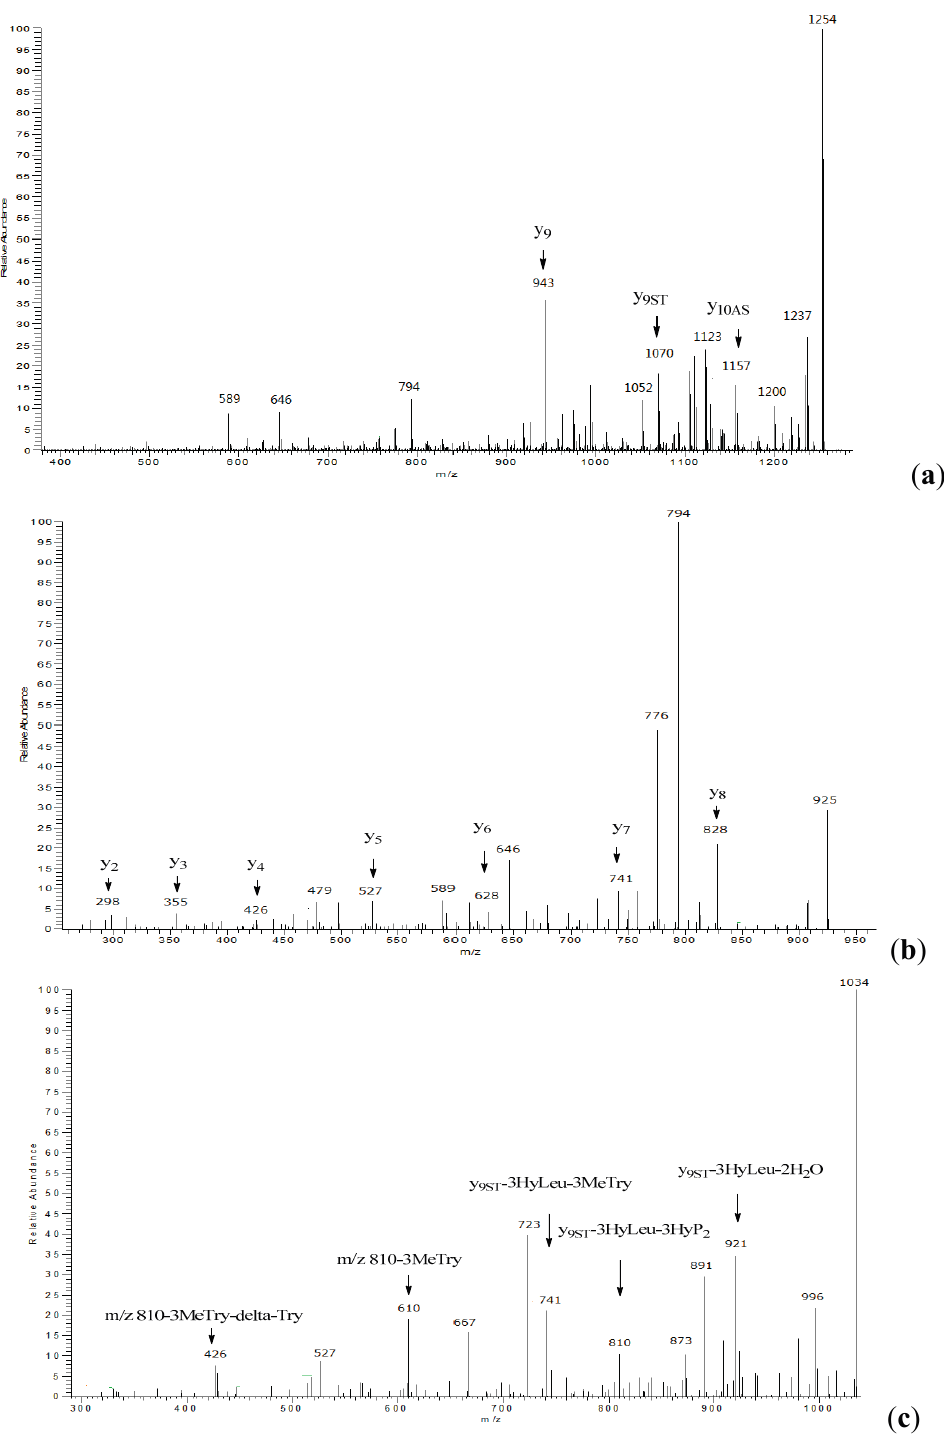
Figure 1. Tandem MS spectra of characteristic ions. ( a ) Product ions of m / z 1272; ( b ) Product ions of m / z 943; ( c ) Product ions of m / z